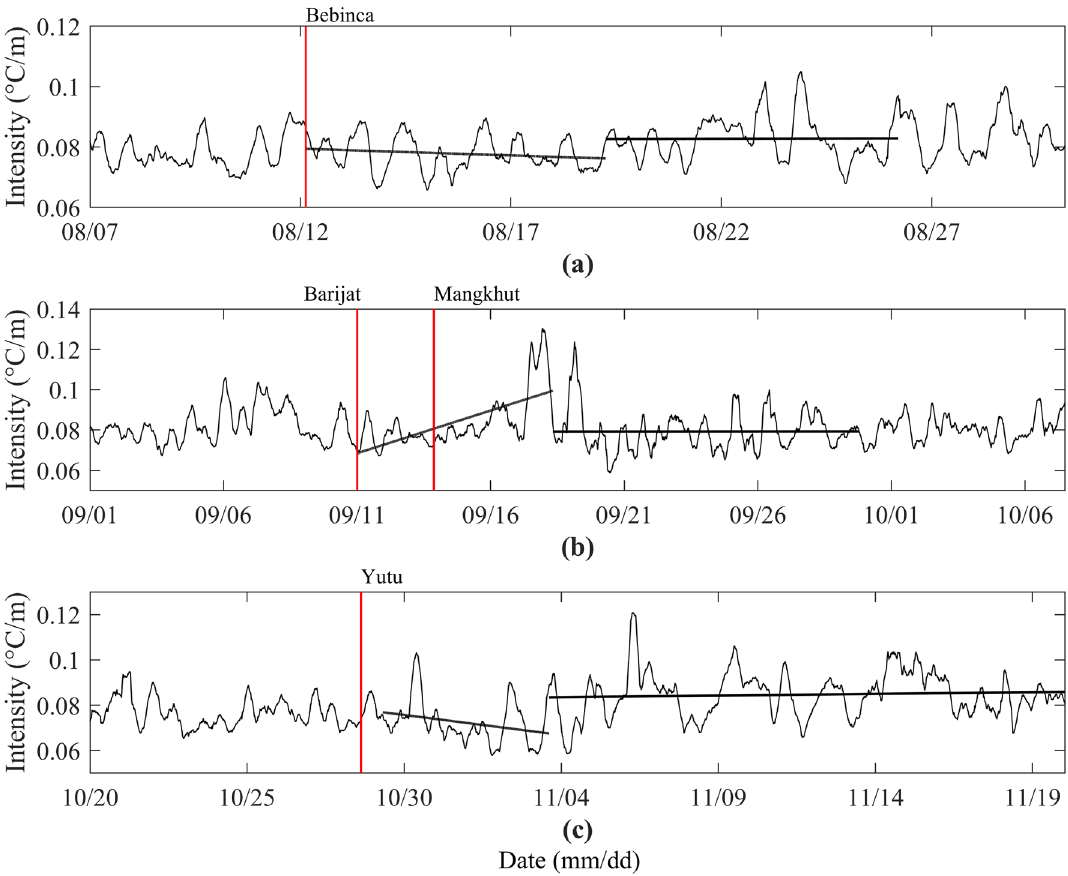
Figure 9. Time series of intensity of the thermocline during the passage of typhoons Bebinca ( a ), Barijat and Mangkhut ( b ), and Yutu ( c ), respectively. The red vertical lines are same as Fig. 1. The black straight lines are fitting curves of intensity of the